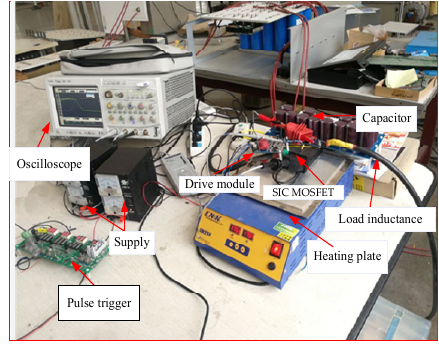
Figure 2. Double pulse experimental platform.